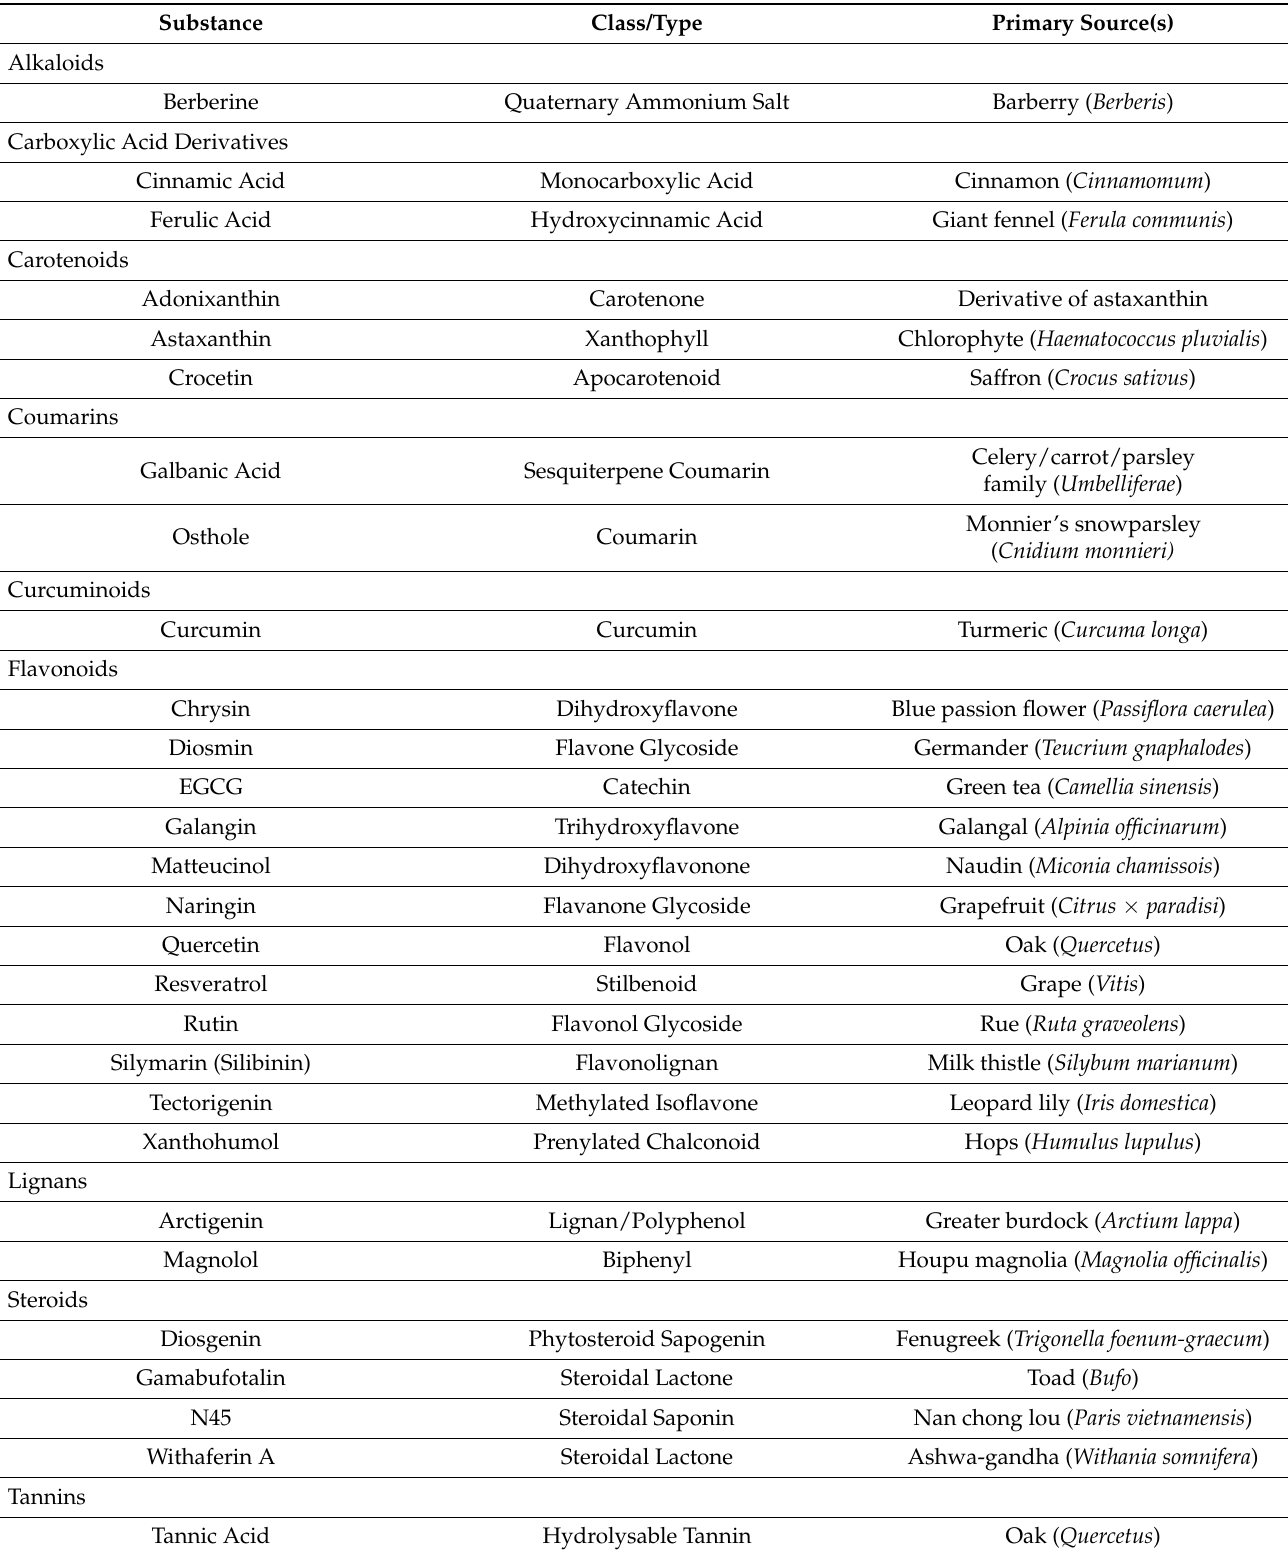
Table 1. Classes and sources of natural substances with anti-GBM efficacy demonstrated in recent preclinical studies. Many of the listed compounds occur in multiple natural